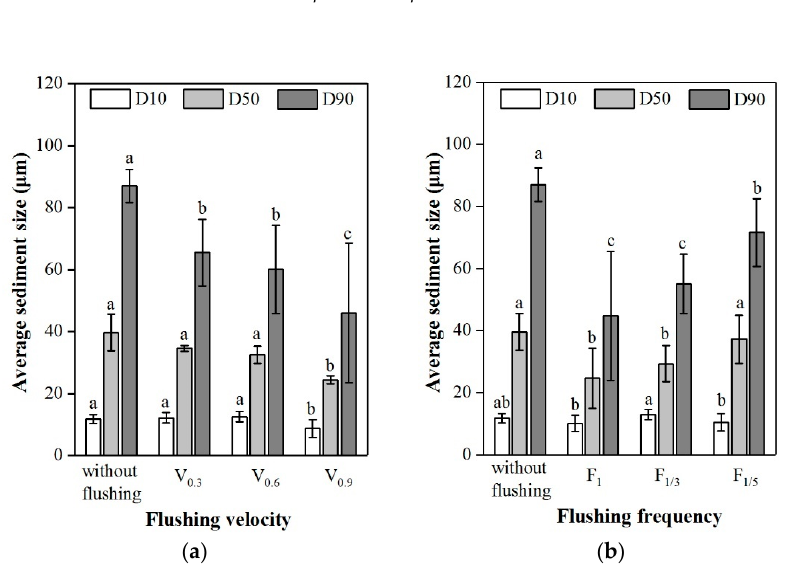
Figure 9. Average and standard error of D10, D50, and D90 at different flushing ( a ) velocities and ( b ) frequencies.